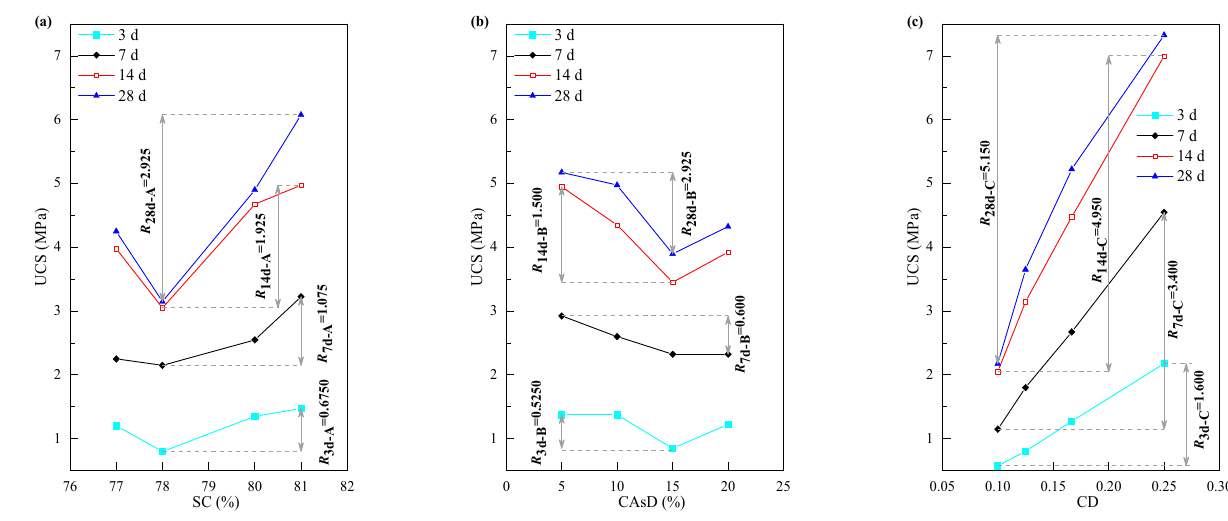
Figure 6. Relation curves of UCS with ( a ) SC (solid concentration), ( b ) CAsD (coarse aggregates dosage), and ( c ) CD (cement dosage) by range analysis.